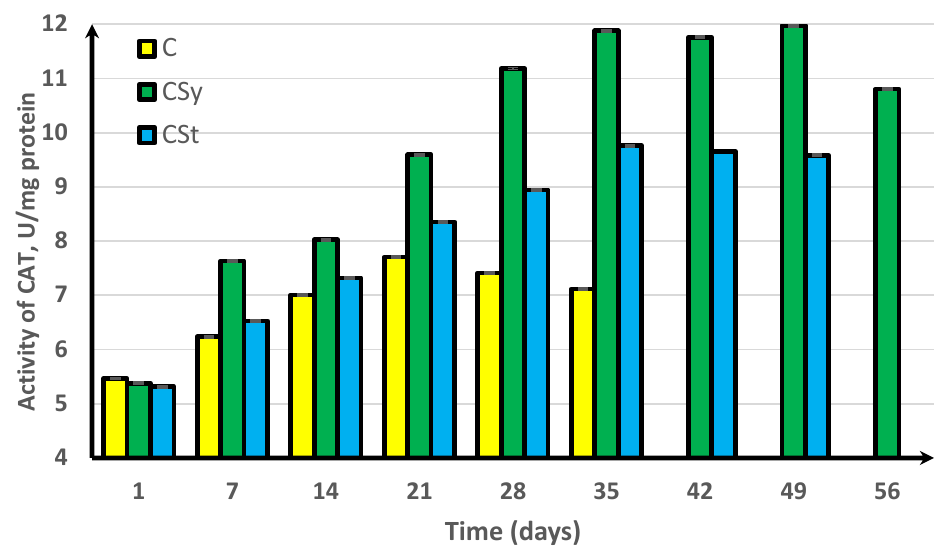
Figure 3. Catalase (CAT) activities in workers’ hemolymph along with the aging processes, after using two methods of supplementation with hemp extract. C, control (pure sugar syrup); CSy, hemp extract in syrup; CSt, hemp extract on strips (two-way ANOVA: days of supplementation: F (5,1078) = 25133, p = 0.0000, se ± 0.010013 (1st–35th days), se ± 0.017343 (42nd day and 56th day), se ± 0.012263 (49th day); supplementation method: se ± 0.00708 (C), se ± 0.00578 (CSy), and se ± 0.00656 (CSt); supplementation method × days of supplementation F (11,1078) = 2701.1, p = 0.0000, and se ± 0.017343). The chart shows statistical averages. The standard deviations for the means in this plot ranged from 0.05238 to 0.21342.